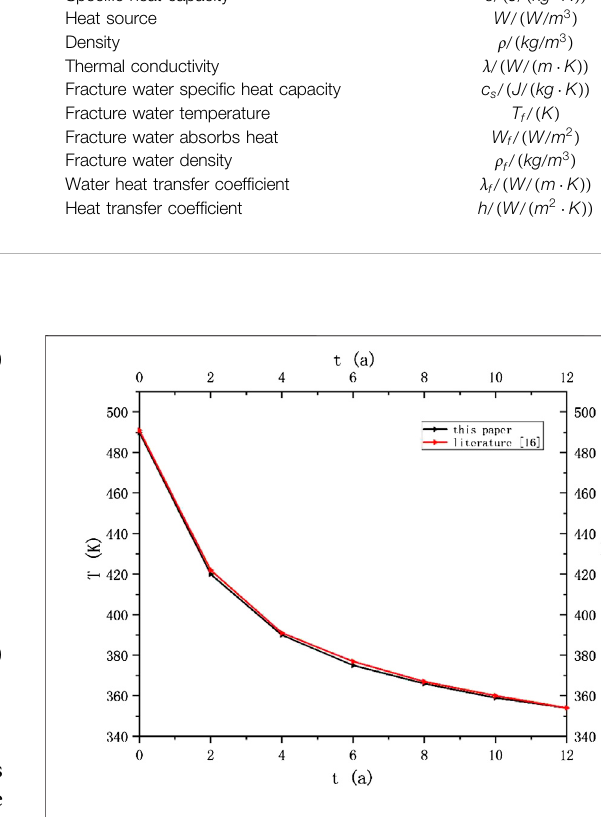
FIGURE 1 | Model veri fi cation